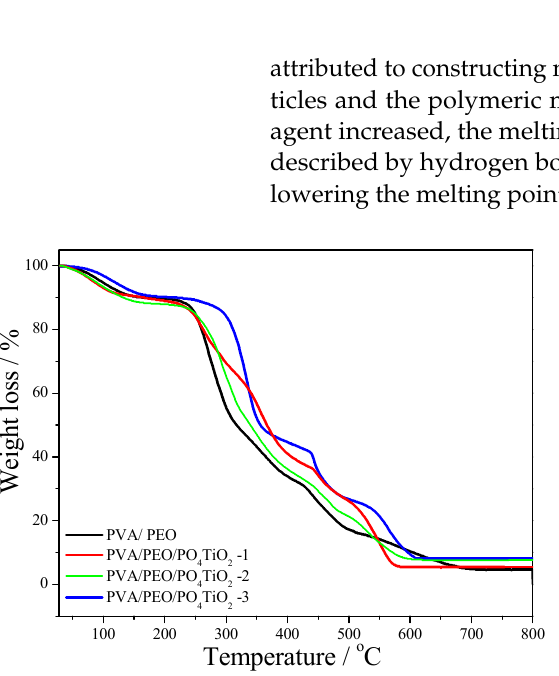
Figure 5. TGA of PVA/PEO/PO 4 TiO 2 membranes ( left chart ) and DSC of PVA/PEO/PO 4 TiO 2 membranes ( right chart ) curves of nanocomposite membranes.